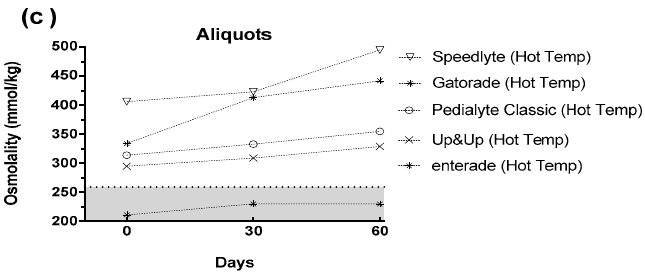
Figure 3. Impact of time and storage conditions on the osmolality of various pre-mixed oral rehydration solutions [ORS] for: ( a ) freshly opened bottles stored at room temperature; ( b ) beverage aliquots stored at room temperature; and, and ( c ) beverage aliquots stored at elevated temperatures. The shaded area denotes the optimal range for beverage osmolality (200–260 mmol / kg; see text for details).